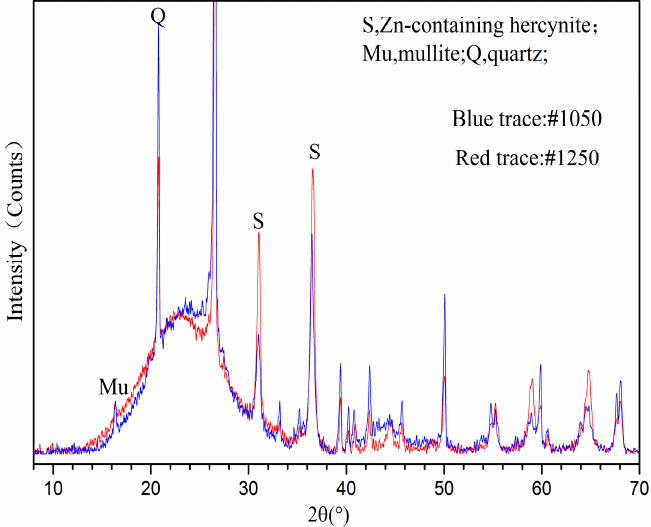
Figure 6. XRD patterns for boiling acid separation residues of 1050 and 1250 °C DTF ash of SH light coal.